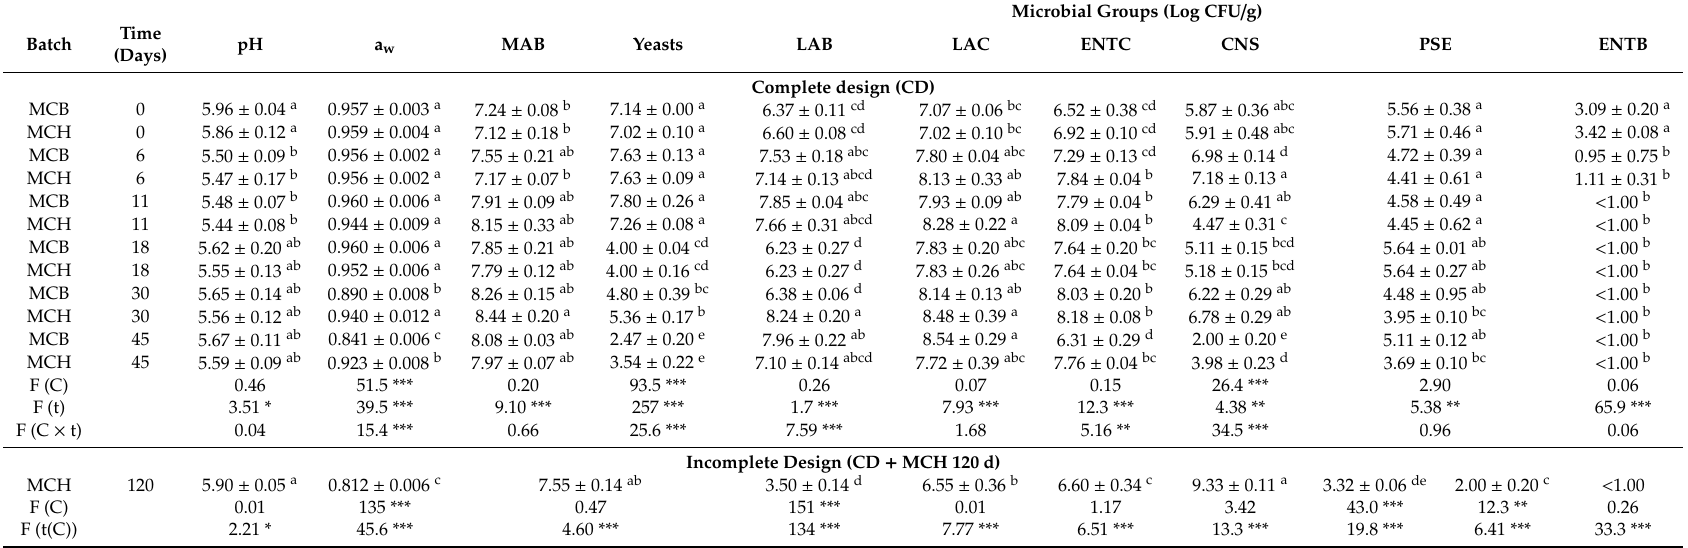
Microbial Groups (Log CFU /